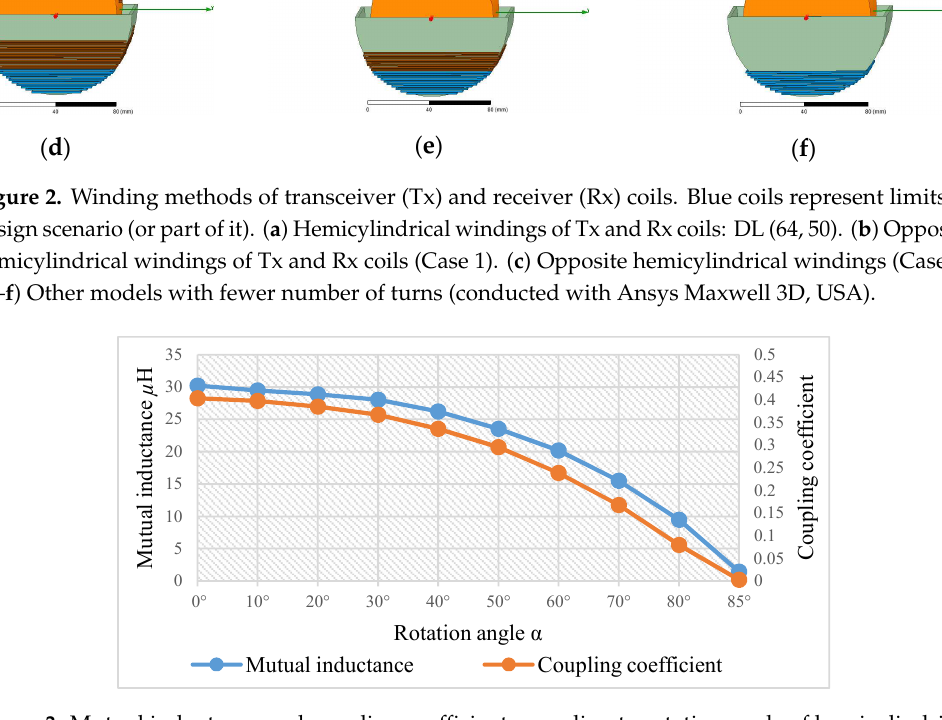
Figure 3. Mutual inductance and coupling coefficient according to rotation angle of hemicylindrical winding structure.